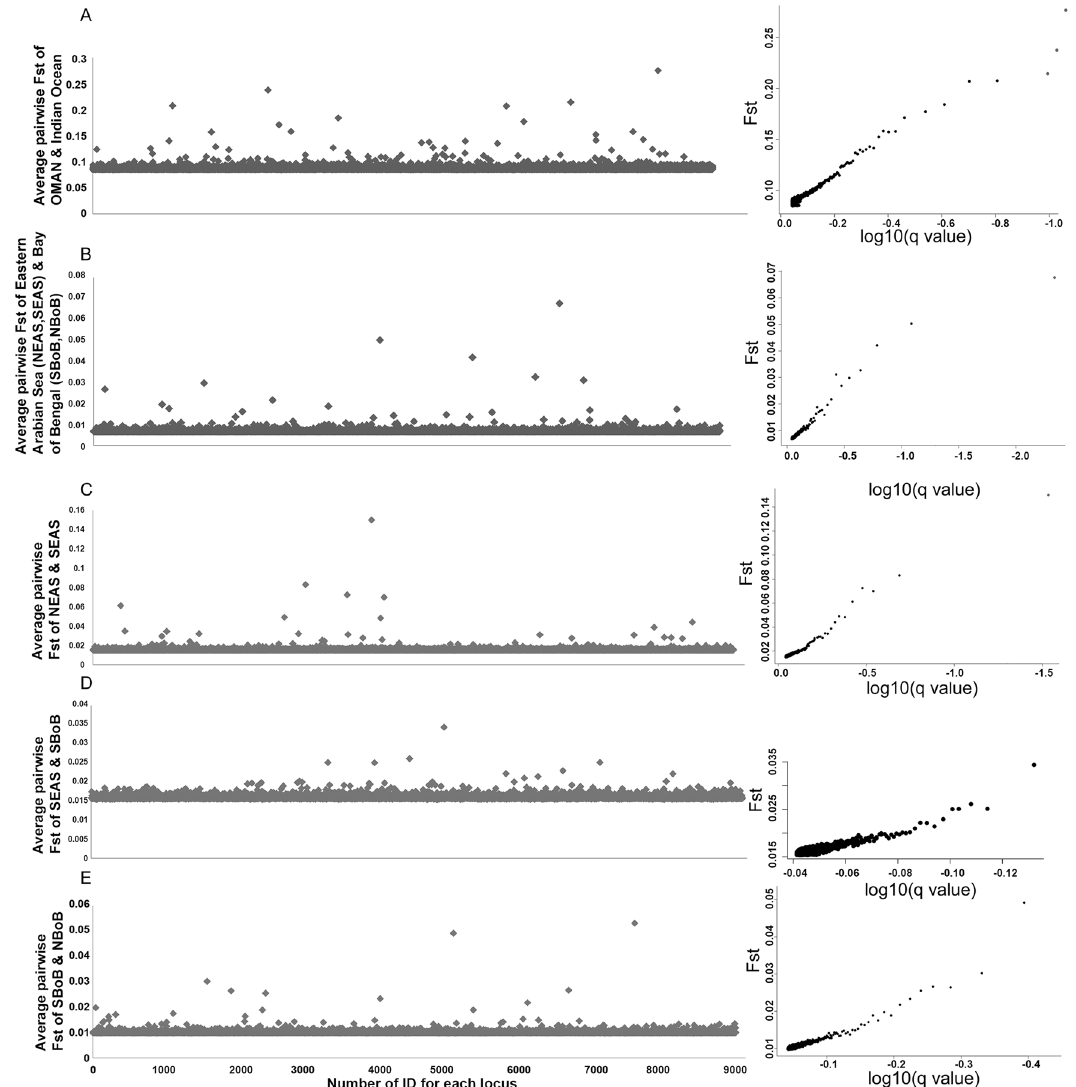
Figure 2. The plot of pairwise F ST of SNP loci potentially subjected to differential selection in S. longiceps populations. Pairwise F ST of SNP loci between ( A ) OMAN and the Indian Ocean, ( B ) Arabian Sea (NEAS, SEAS) and Bay of Bengal (SBoB, NBoB), ( C ) NEAS and SEAS, ( D ) SEAS and SBoB, and ( E ) SBoB and NBoB. For the figures on the left, X-axis indicates the number of IDs for each locus and the Y-axis indicates the pairwise F ST values. For the figure on the right, X-axis indicates the false discovery rate (FDR) and Y-axis indicates the pairwise F ST values. The SNP loci with a false discovery rate (FDR) < 0.05 were highlighted in red colour. The plot was generated with R statical package (https:// www.r- proje ct. respectively (Supplementary Figs. S5 and S6). Besides, low Chl- a (0–3 mg/m 3 ) and low SSS (28–33 ppt) were also observed throughout the year (Fig. 3, Supplementary Figs. S5 and S7). Among these five eco-regions, OMAN associated with the Gulf of Oman upwelling zone (with an aver- age of 195,450.00 tons/year) followed by SEAS associated with Malabar upwelling zone (with an average of 156,910.95 tons/year, 1985–2019) contributed the largest share of Indian oil sardine fishery. Landings of Indian oil sardine exhibited large interannual variability with abundant (above average) and deficient years (below average) during the past 35 years (Supplementary Fig. S8). The highest landing in India was observed during 2011–2012 (with an average of 216,172.6 tons/year) and intermediate during 2002–2007 (with an average of 98,148.32 tons/ year). The lowest landing was observed during 1984–1987 (with an average of 24,906.91 tons/year), 1993–1995 (with an average of 16,569.33 tons/year) and 2017–2019 (with an average of 56,099.66 tons/year). Chlorophyll- a has been used as a proxy for productivity and sardine abundance as S. longiceps is consid- ered a plankton feeder with a preference for diatoms like Fragilaria oceanica 42,43 . It is observed that the average monthly Chl- a was low during May to September for years with lower sardine fishery and high for years with higher sardine fishery (Supplementary Fig. S9), which also has been established by previous investigations 29,44 . The temperature of SEAS was above average through May (pre-spawning) to September (spawning and larval